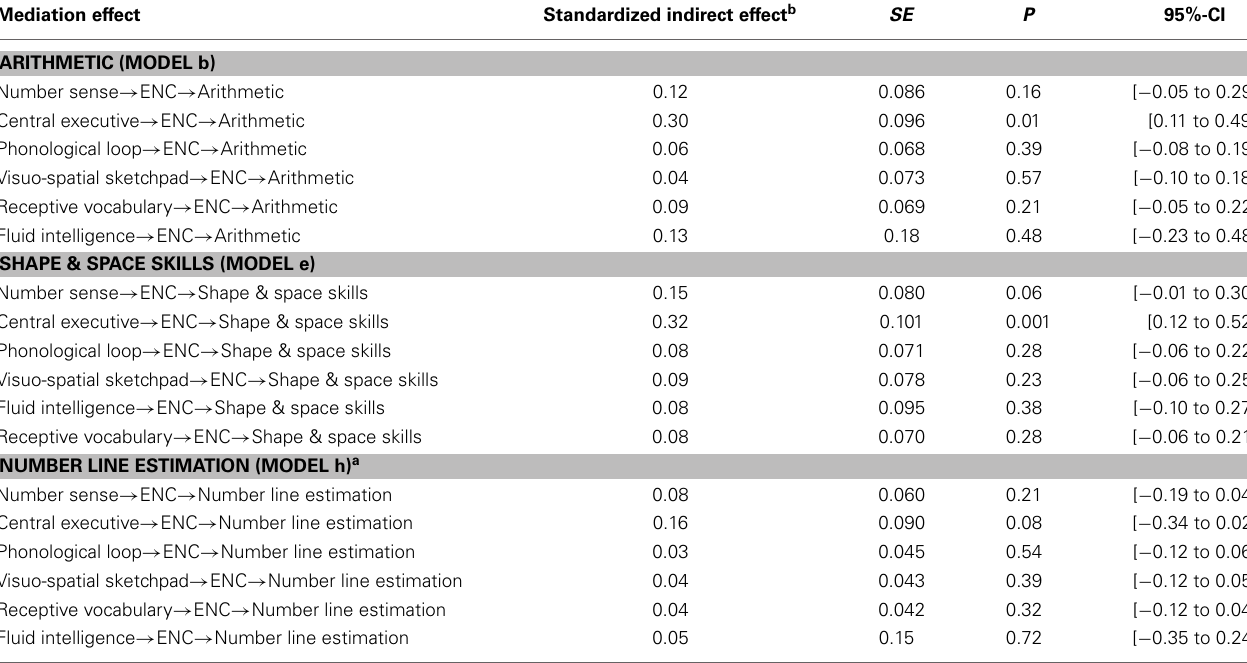
Table 5 | Standardized indirect mediation effects, significance tests and bootstrapping confidence intervals for the three best-fitting SEM